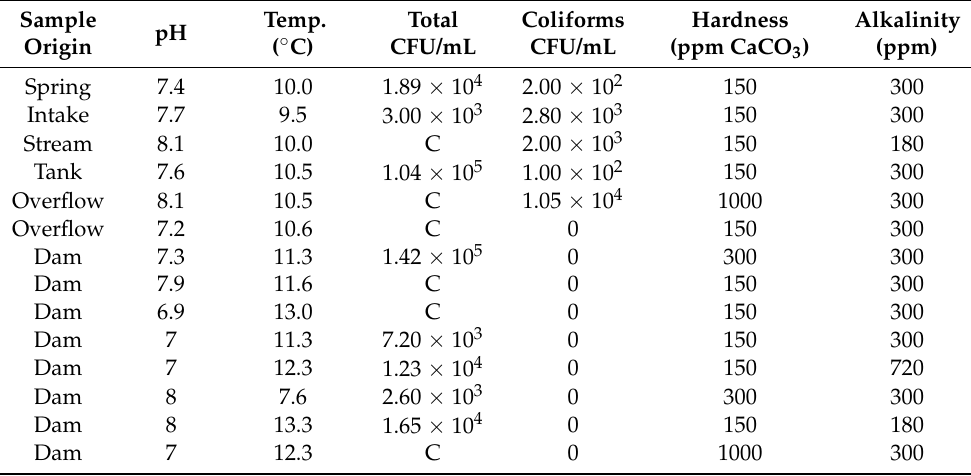
Table 1. Physico-chemical and microbiological characteristics of the water